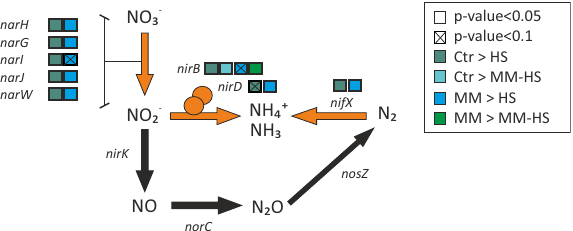
Fig. 7 Nitrate metabolic pathways and halitosis. The diagram represents the nitrate metabolism reactions that were differentially expressed (orange arrows) between the tongue metatranscriptome of halitosis-free individuals and halitosis patients, as well as additional reactions that involved nitrogen-related metabolites (black arrows). The over-expression (DESeq2 test) of a gene in a group is indicated by a coloured